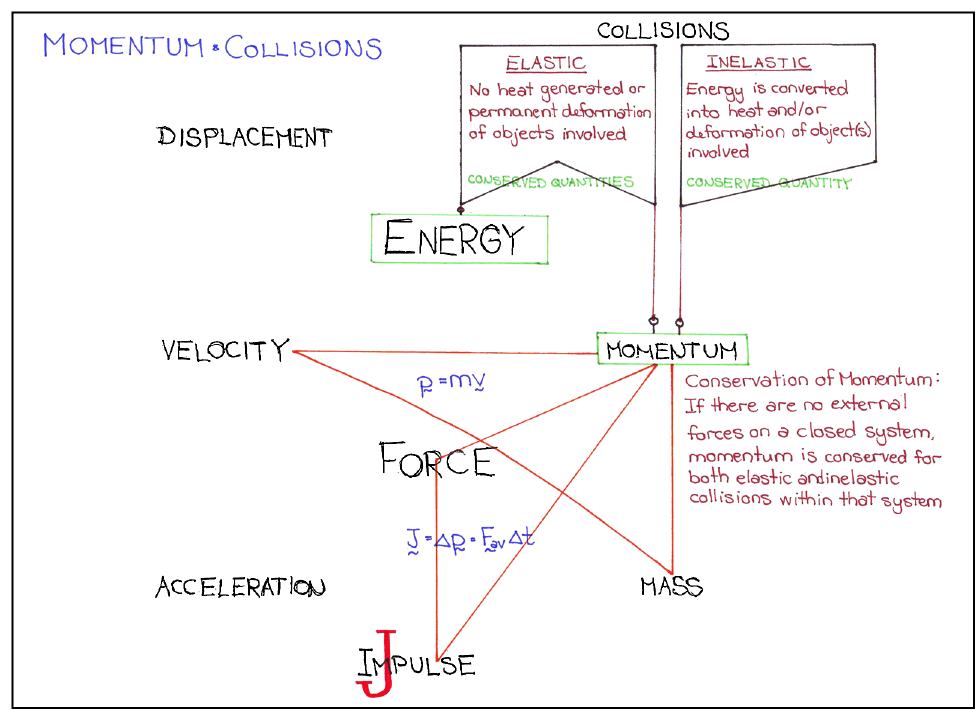
FIG. 1 (color online). Momentum and collisions map for the Fundamentals class.